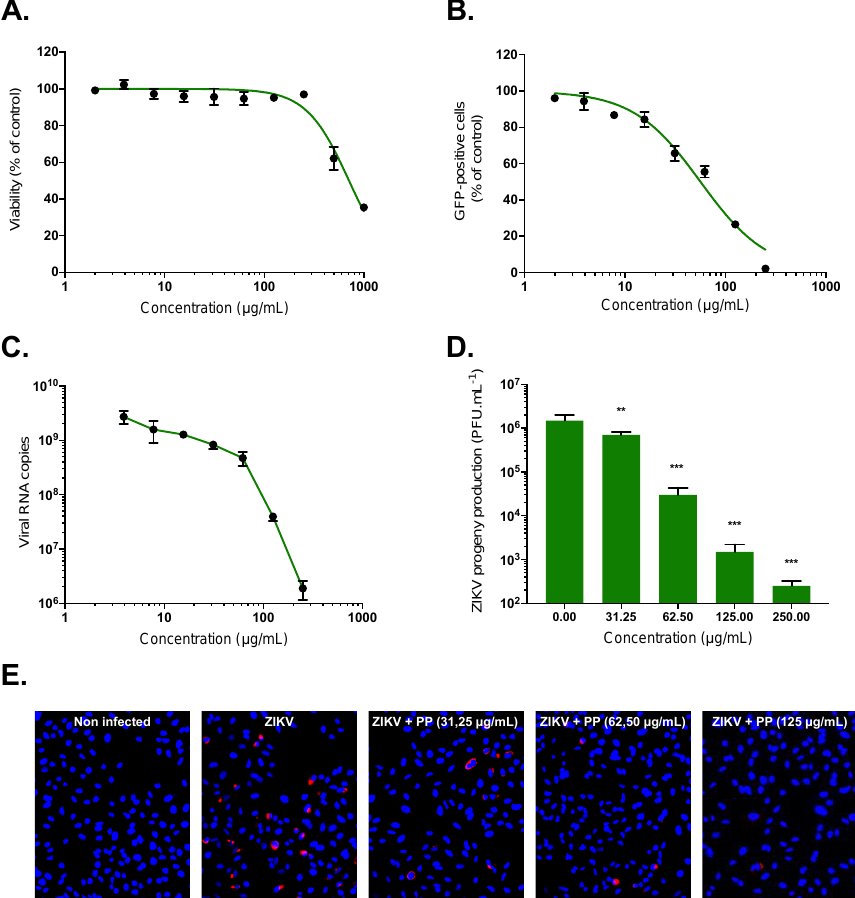
Figure 1. Phyllanthus phillyreifolius extract exhibits antiviral activity against African and Asian strains of Zika virus (ZIKV). ( A ) A549 cells were incubated with two-fold serial dilutions (1000 to 2 µ g / mL) of plant extract for 72 h. Cell viability was evaluated using an MTT assay. ( B ) A549 cells were infected with ZIKV GFP at MOI of 1 in presence of different concentrations (250, 125, 62.5, 31.25, 15.60, 7.80, 3.90, and 2 µ g / mL) of P. phillyreifolius . Flow cytometric analysis of GFP fluorescence was performed 24 h post-infection. A549 cells were infected with ZIKV-PF13 at MOI of 2 and continuously incubated with increasing concentrations of P. phillyreifolius (PP). ( C ) The amount of viral genomic RNA in ZIKV-PF13-infected A549 cells was determined by RT-qPCR. ( D ) ZIKV progeny production was quantified by plaque-forming assay. The results shown are means ± SD of four independent experiments and are expressed as relative value compared to untreated infected cells. ** p < 0.01; *** p <0.001, **** p <0.0001, n.s. = not significant. ( E ) Immunofluorescence analysis of viral protein expression in ZIKV-PF13-infected A549 cells. The ZIKV (red) and nuclei (blue) were visualized by fluorescence microscopy. Scale bars are 50 µ m. Results from a representative experiment (n = 3 repeats) are shown.